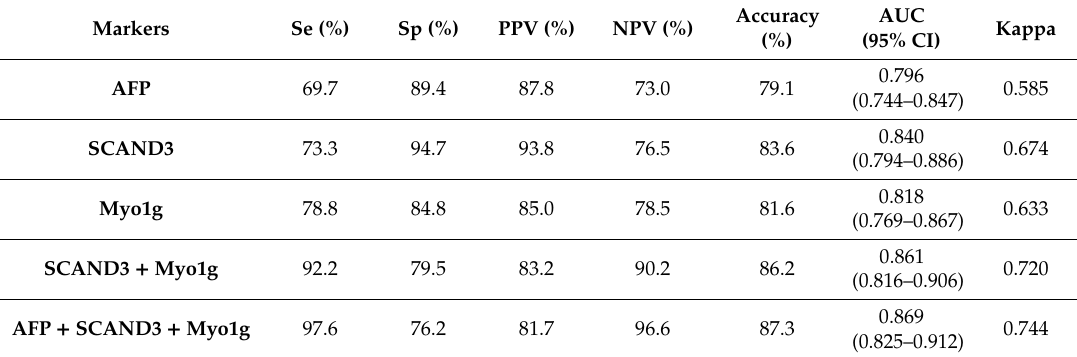
Table 1. Diagnostic values of serum gene methylation markers and AFP in predicting HCC. Markers